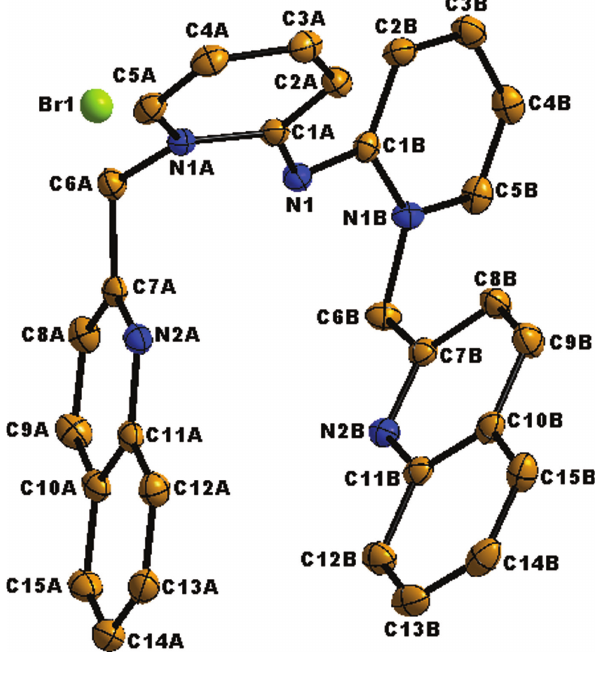
Table 1: Data collection and handling.